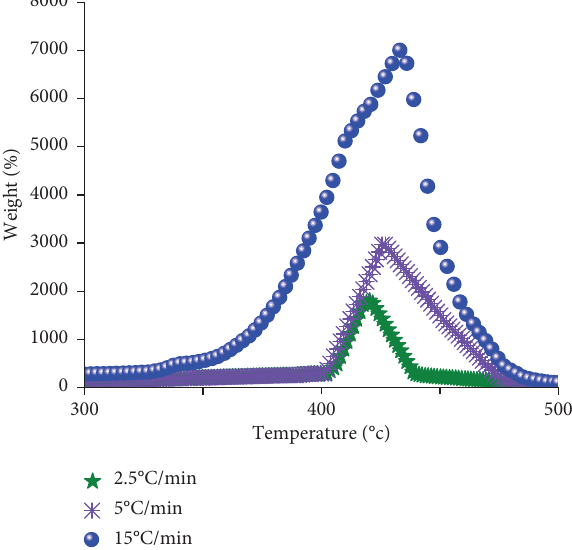
Figure 5: DTG curves of ACM-CB70 composites at diferent heating rates under nitrogen atmosphere.